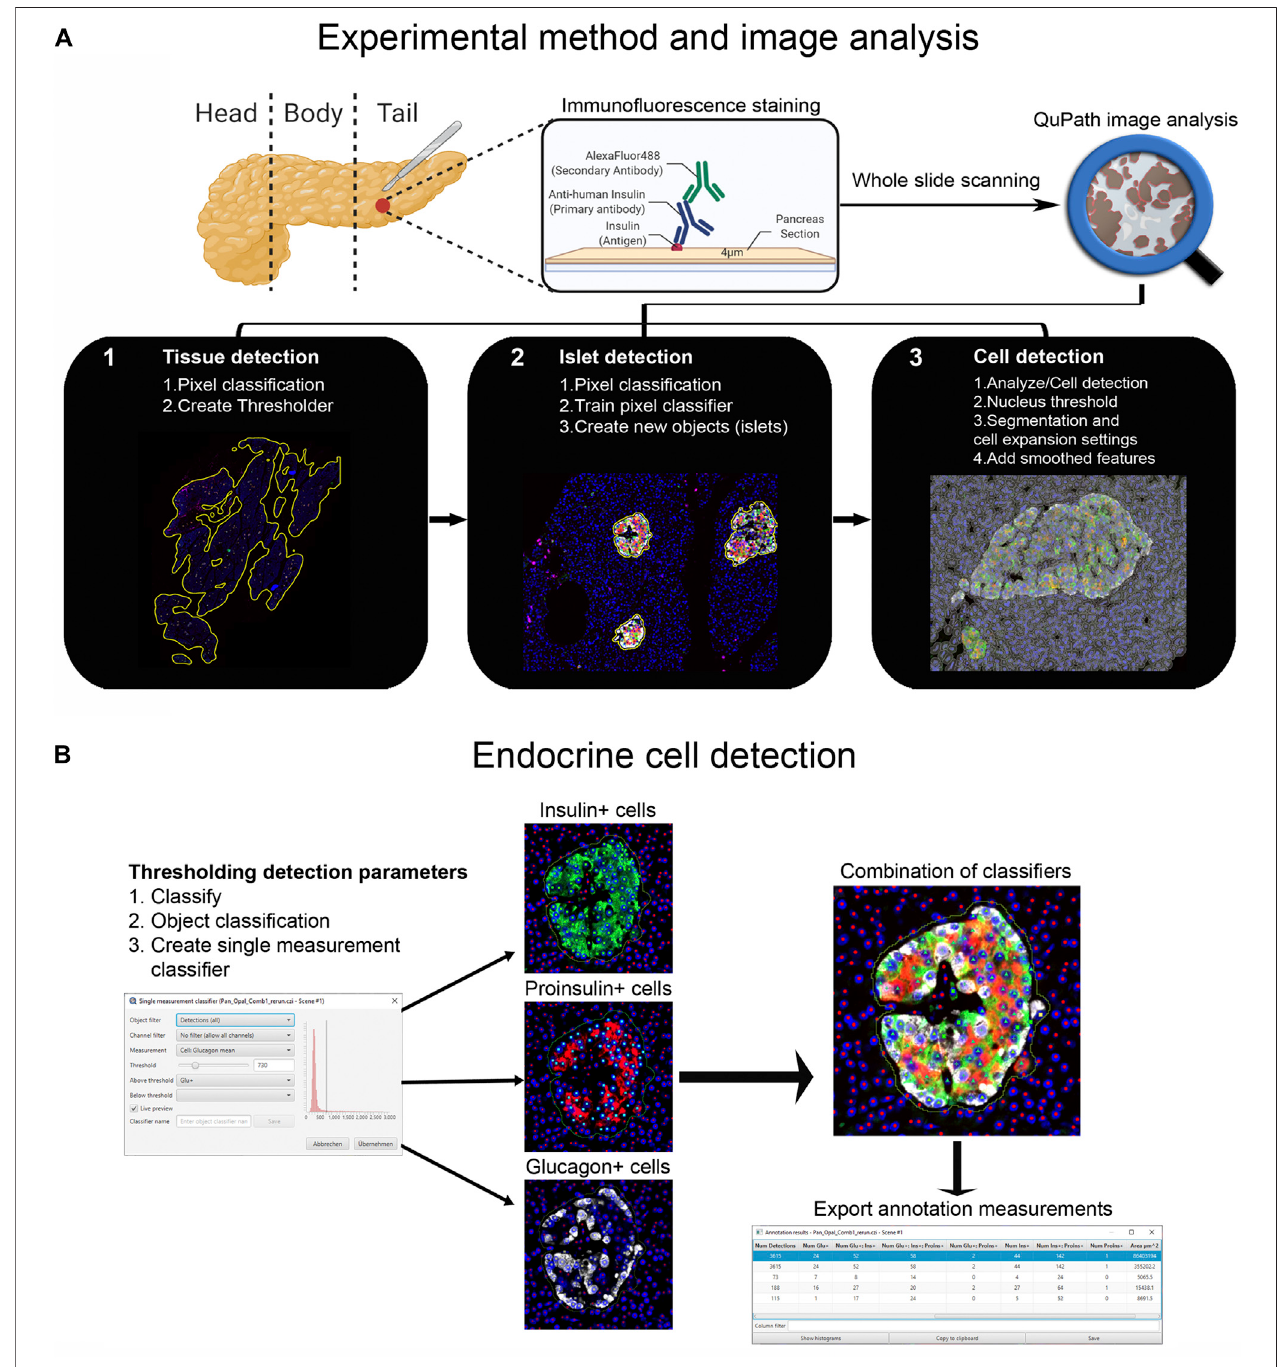
FIGURE 1 | Schematic illustration of the whole-slide image analysis work fl ow using QuPath. (A) Experimental method and image analysis. Multiple immuno fl uorescence protocols were employed for the staining of tissue sections from the pancreatic tail ofa single non-diabetic donor. Whole-slide image analysis was carried out with QuPath, version 0.2.3 1); tissue was detected using an intensity thresholder based on average values of all channels for the labeled proteins 2), Objects (islets) were then created using the pixel classi fi er, and 3) cells were detected and smoothed features were added. (B) The Single measurement classi fi er tool was employedtodetectpositivecellsforthemarkerofinterest.Cellswereidenti fi edasareasofstainingabovethebackgroundlevelbyapplyingoptimized Cellmean intensity thresholds.Combinationofsingleclassi fi erswasnecessaryfortheaccuratedetectionofbetaandalphacells.AnnotationmeasurementswereexportedasCSV fi lesand were subsequently processed in Excel